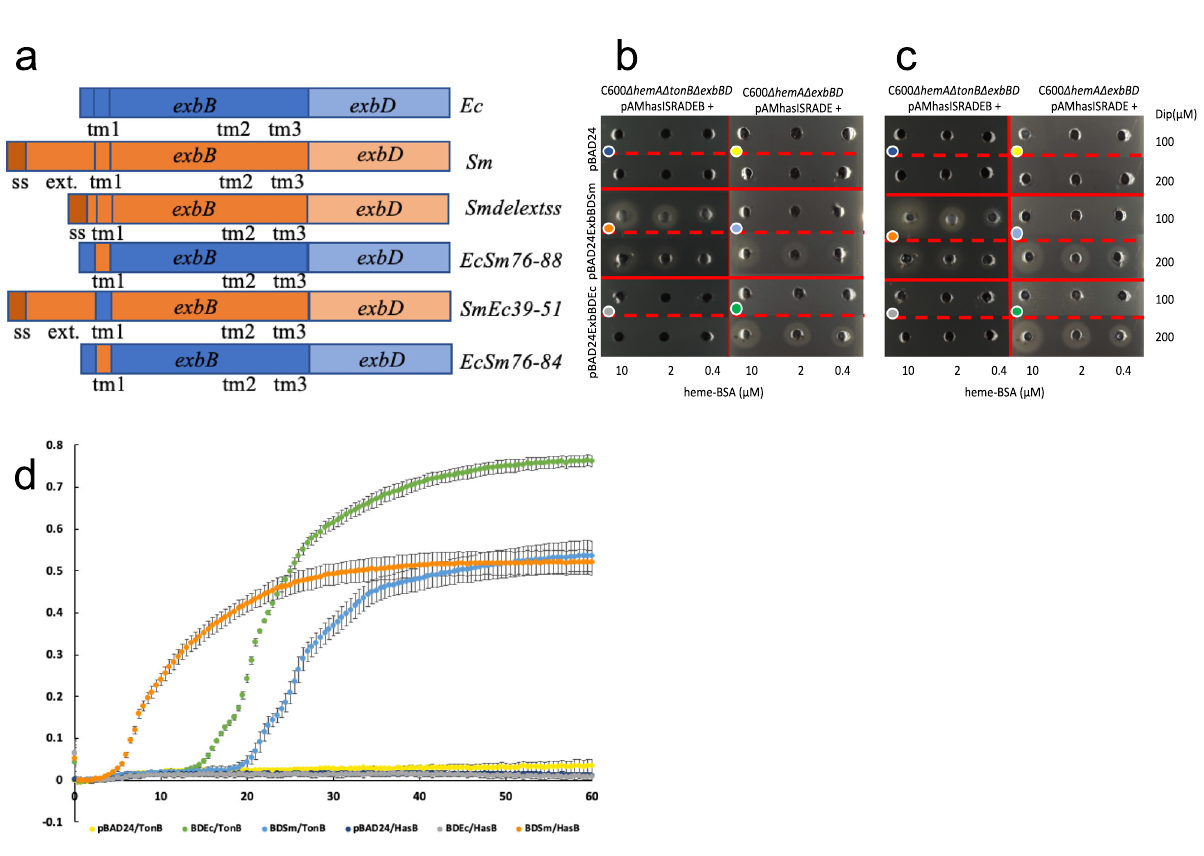
Fig. 3 Role of HasB and TonB on bacterial growth. a Representation of the constructions used in b – d , and elsewhere in this work. ss refers to the signal sequence, ext to the periplasmic extension of ExbB Sm , and tm1, tm2, and tm3 to the fi rst, second, and third ExbB transmembrane segments, respectively. b , c Growth around wells of E. coli C600 Δ hemA Δ tonB Δ exbBD harboring pAMHasISRADEB and speci fi ed recombinant plasmids ( b , c left parts) or E. coli C600 Δ hemA Δ exbBD harboring pAMHasISRADE and speci fi ed recombinant plasmids ( b , c right parts); the pictures were taken after overnight growth at 37 °C ( b ), or after 36 h growth ( c ). Arabinose concentration was 40 µ g/ml. Dipyridyl (DiP) iron chelator concentration was either 100 or 200 µ M. Heme- BSA concentrations inside the wells were 10, 2, and 0,4 µ M. d growth curves in microplates of the same strains as in b , c ; DiP concentration was 100 µ M in the C600 Δ hemA Δ exbBD (pAMHasISRADE) derivatives, and 40 µ M for C600 Δ hemA Δ tonB Δ exbBD (pAMHasISRADEB) derivatives, arabinose concentration 4 µ g/ml, Heme-BSA 1 µ M. The error bars correspond to standard error calculated from the duplicate measurements. Colored dots in ( b , c ) refer to the equivalent growth conditions in ( d